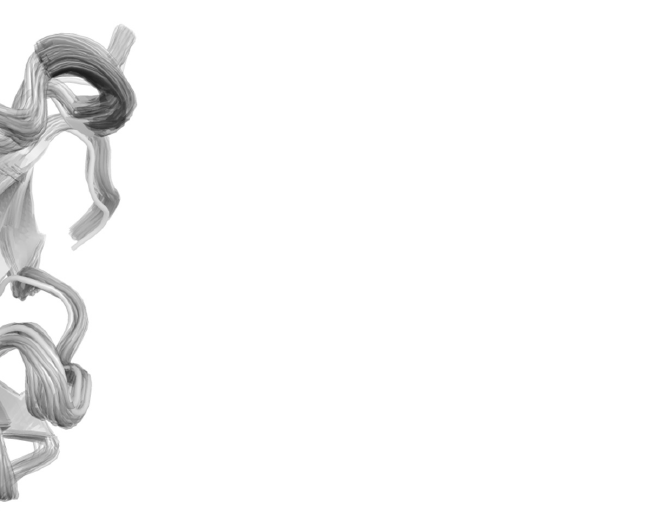
Figure 2. Distances for the identified Zn(II) ligands to the metal ion along each of the three 30 ps QM/MM MD trajectories for the C132A mutant of the P2X4R head domain. ( a – c ) Zn(II)-Ligand dis- tances for three different trajectories. Blue: C126, Red: N127, Green: C132, Black: C159.